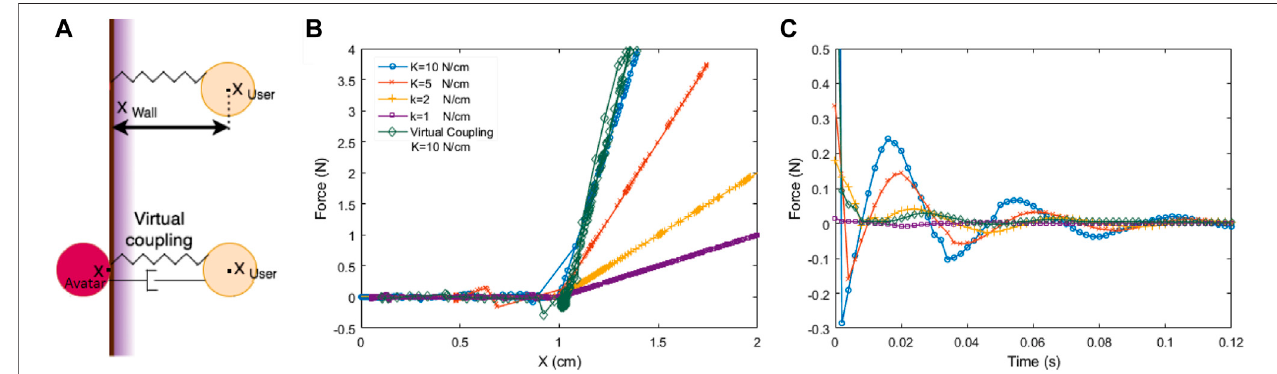
FIGURE 4| Rendering ahaptic wall, using a virtual coupling to achieve both high stiffness and stability. (A) Algorithm schematic. (Upper) In the simplest rendering method, force depends directly on the distance between the virtual wall and the user ’ s hand (haptic device) as it penetrates the wall: F (cid:1) K ( X wall – X user ). (Lower) A virtual coupling establishes an avatar where X user would be if we could render a wall of in fi nite stiffness, and imposes a virtual damped-spring connection between X user and X avatar . (B) Force-displacementbehaviourwhenthewallisrenderedasadirectstiffnessorthroughavirtualcoupling.TheVCusedherealsousesthemaximum K (cid:1) 10 N / cm , and achieves a similar stiffness as when this K value is used on its own. (C) Oscillatory behavior of the conditions from (B) . In direct rendering, instability increases with K , but with a VC, a high K is as stable as the softest direct-rendered wall. (B) and (C) show data sampled from a Haply device.